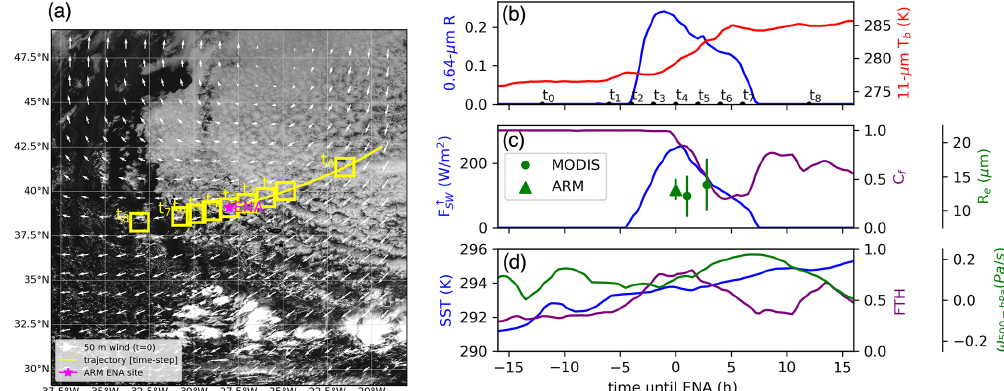
Figure 2. (a) Lagrangian trajectory (yellow line) initialized at ENA on 27 October 2018 at 12:00LT computed using HYSPLIT and MERRA- 2 products is plotted over the GOES-16 visible image (0.64µm reflectance). The trajectory spans two 16h periods (backward and forward). (b) Visible reflectance and 11µm brightness temperature from GOES-16; (c) CERES SYN top-of-atmosphere (TOA) outgoing shortwave ↑ , blue) and cloud fraction (purple) with droplet effective radius from MODIS (green circle) and ARM (triangle; vertical lines flux ( F SW denote 1 standard deviation in the retrievals); and (d) sea surface temperature (SST; blue), free-tropospheric relative humidity at 850hPa (FTH; purple), and subsidence rate at 500hPa ( ω 500hPa ; green) interpolated in time and space to the trajectory in 15min intervals.